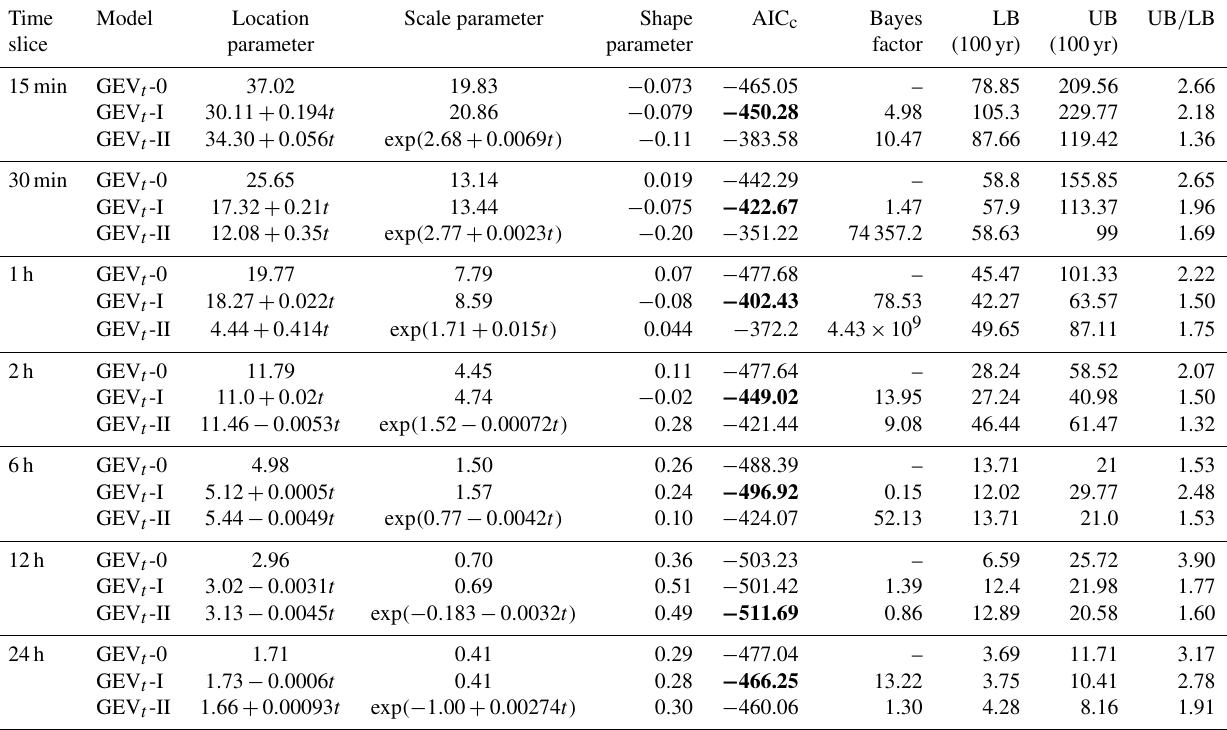
Table 2. Performance of stationary and nonstationary models for Toronto Pearson International Airport. Time Model Location Scale parameter Shape slice parameter parameter